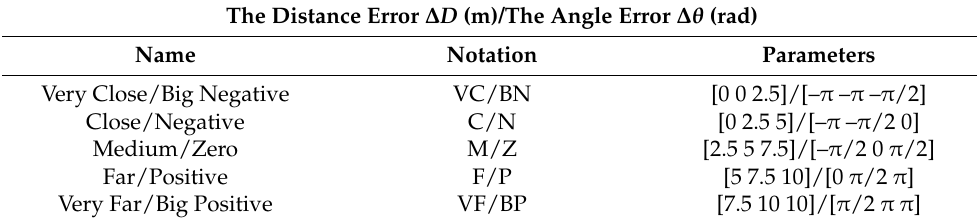
Table 1. Parameters used for inputs of the initial fuzzy logic controller.